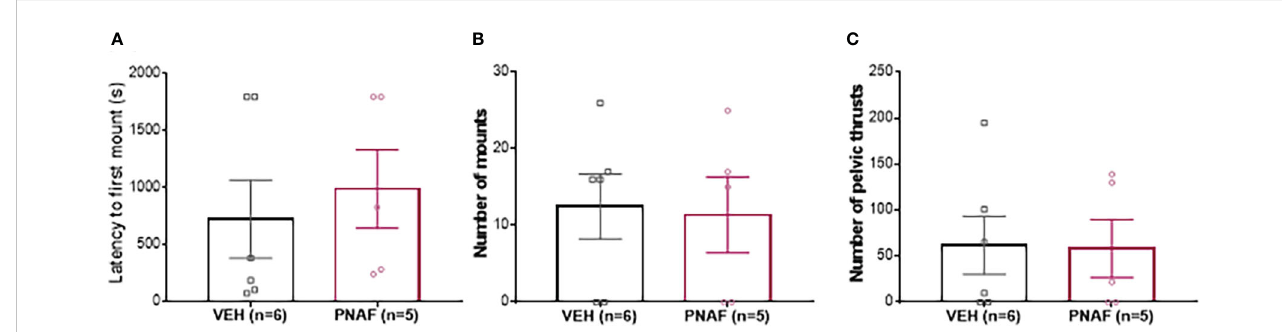
FIGURE 4 Prenatal DHT exposure does not masculinize behavior in the prenatally-androgenized female mouse modeling PCOS. (A) Histogram representing the latency to fi rst mount for VEH female (black bar) and PNAF (magenta bar). (B) Histograms representing the number of mounts for VEH female (black bar) and PNAF (magenta bar). (C) Histograms representing the number of pelvic thrusts for VEH female (black bar) and PNAF (magenta bar). VEH, control female; PNAF, prenatally androgenized female. Mean +/- SEM.